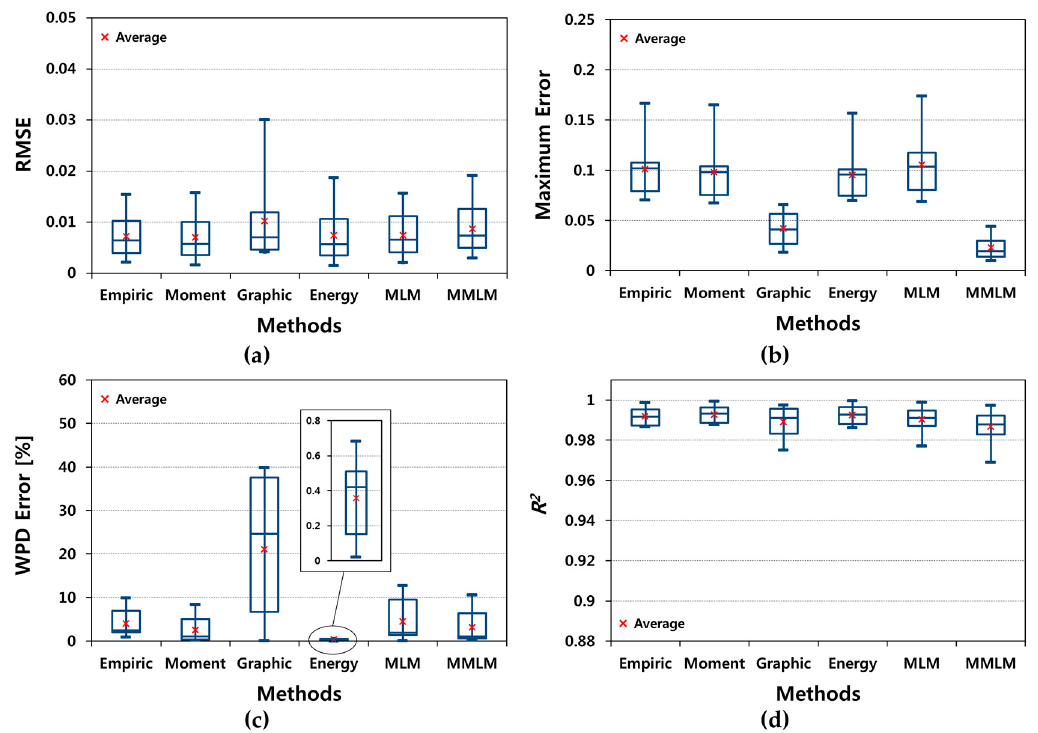
Figure 6. The accuracy test performance of each method. ( a ) RMSE; ( b ) Maximum error; ( c ) WPD error; ( d ) R 2 . Table 7. The results of the accuracy tests according to the topographical